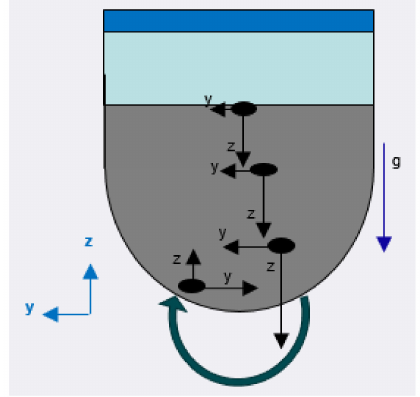
Figure 7. Combination of the forces in a trough along the depths (side